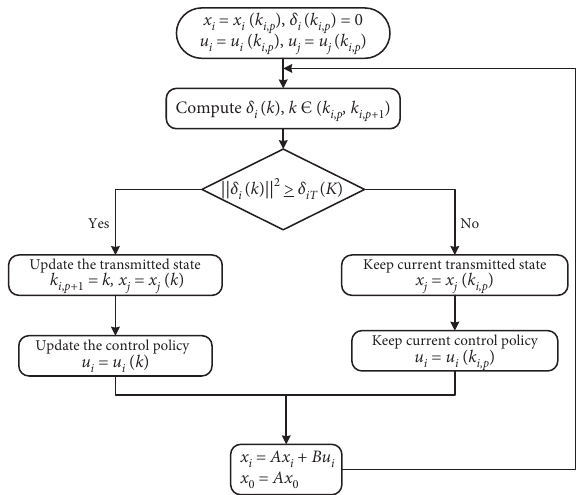
Figure 1: The flowchart of the event-triggered consensus control